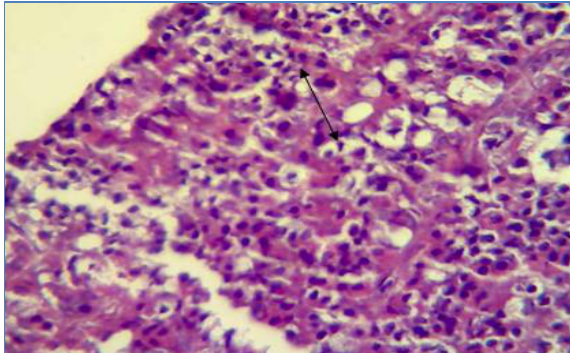
Figure, 5: Section in pituitary gland of animal treated with cadmium chloride and Eruca Sativa (G2) shows few vacuolation in the pars distalis ( ), (H and E stain 10X).